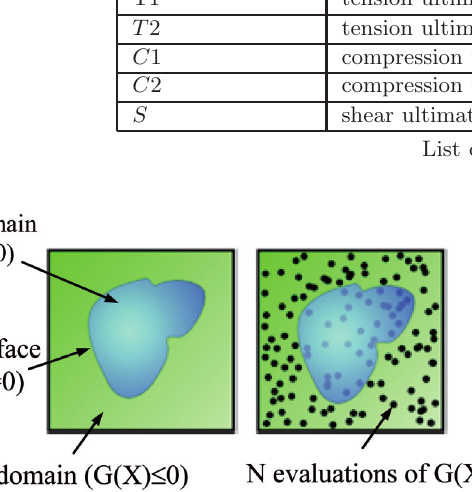
Fig. 1. Monte Carlo simulation